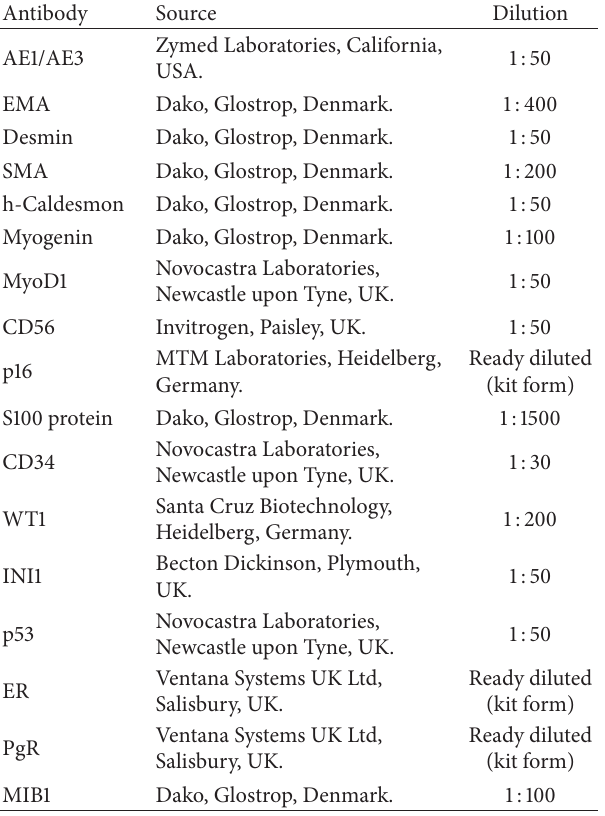
Table 1: Antibodies used for